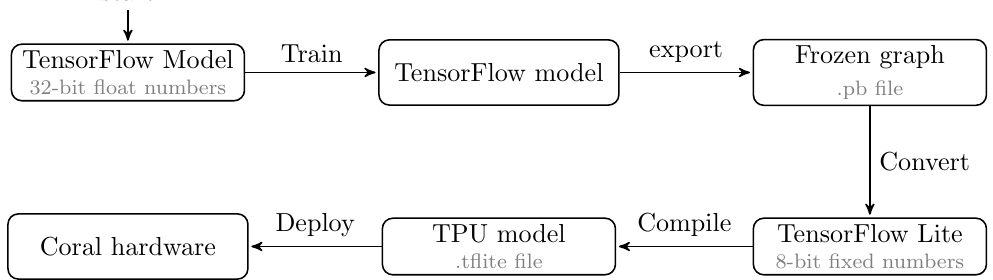
Figure 4. Tool flow for embedding a model on the Coral Dev Board. On top is the standard training procedure, at the bottom, the specific steps to export the trained model to the